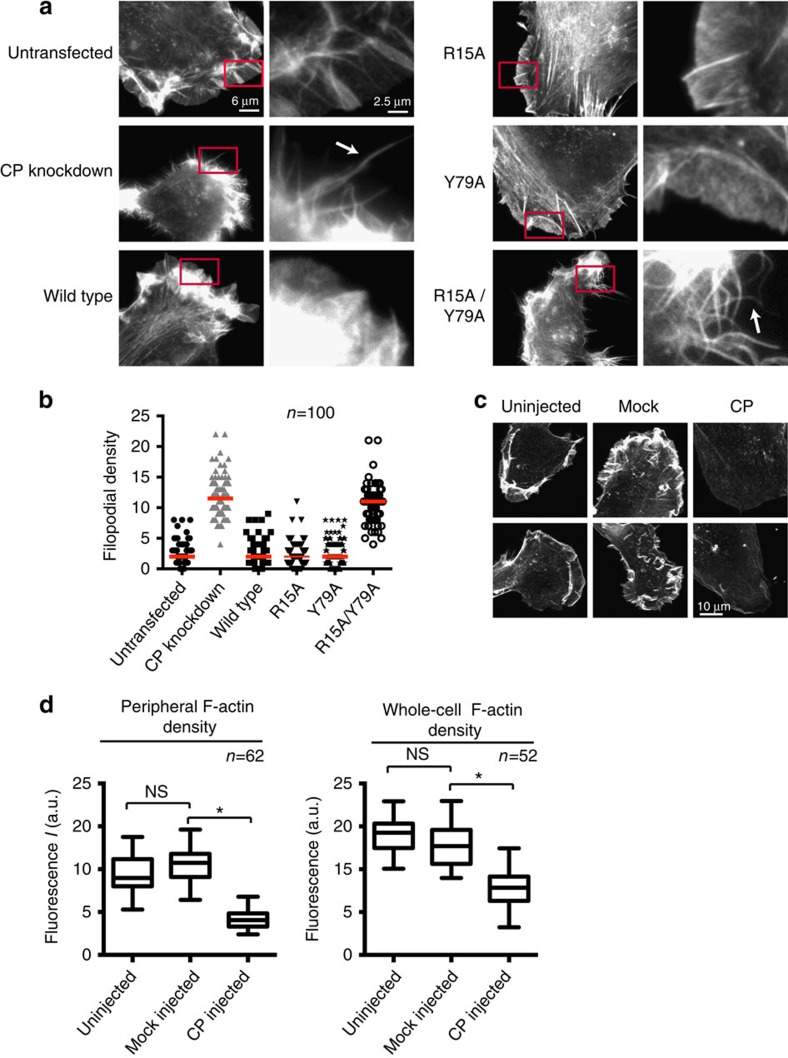
Overexpression of CP R15A/Y79A mutant mimics depletion of CP.(a) Cells were transfected with the indicated constructs and stained with fluorescent phalloidin. Arrows indicate filopodial protrusions. Red boxes in left panels are magnified to the right. (b) Quantification of filopodia density. The y axis is the number of filopodia per 10 μm of cell perimeter; n=100 cells. (c) Increased cellular CP did not affect F-actin organization. Cells were microinjected with a mixture of purified wild-type CP (78.5 μM) and a fixable rhodamine-dextran marker. Cells were stained with fluorescent phalloidin. Mock-injected cells received only the rhodamine-dextran marker. Maximum-intensity projections of confocal images are shown. (d) Quantification of whole-cell and cortical phalloidin staining densities from c. The difference between CP-injected and mock-injected cells is statistically significant (*P<0.01), whereas the difference between mock-injected and uninjected cells is not. NS, not significant.